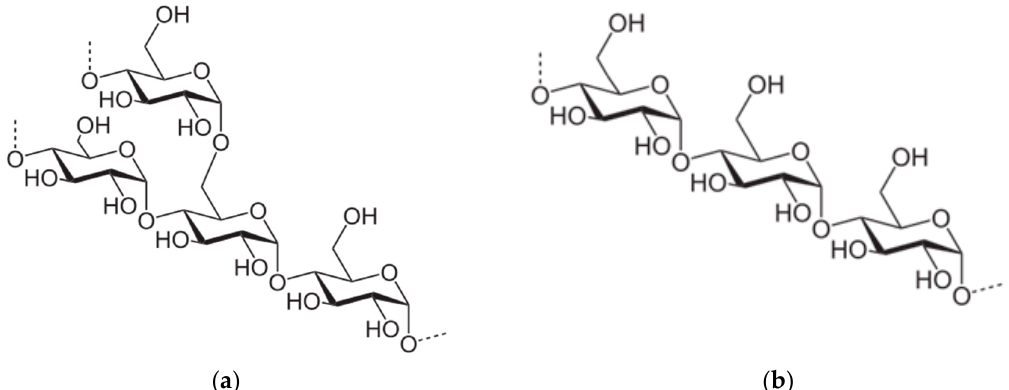
Figure 5. Chemical structure of starch components: amylopectin ( a ); and amylose ( b ).